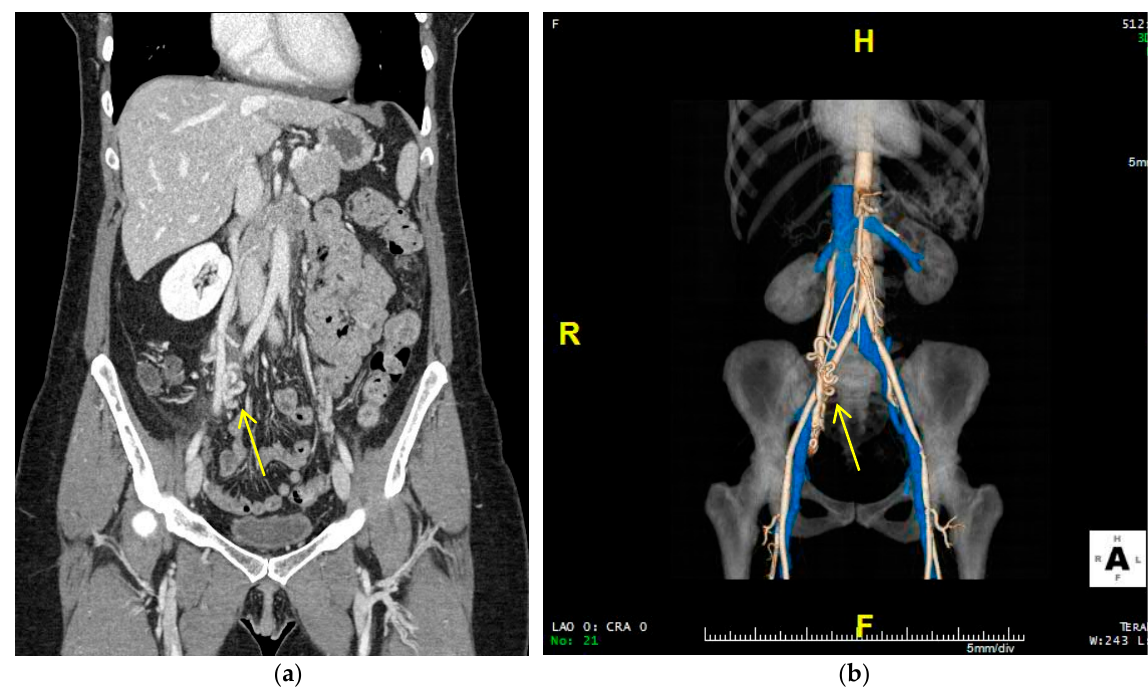
Figure 2. CT and computed tomography angiography (CTA) images of pelvic AVM. ( a ) The CT image on the left shows a conglomerate of tortuous vessels. ( b ) The CTA image on the right allows for better spatial resolution to visualize AVM morphology. Both modalities show a potential Cho–Do type II nidus with abnormal feeder connections from the infrarenal abdominal aorta and anterior division of the interior iliac artery and abnormal drainage to the right gonadal vein.